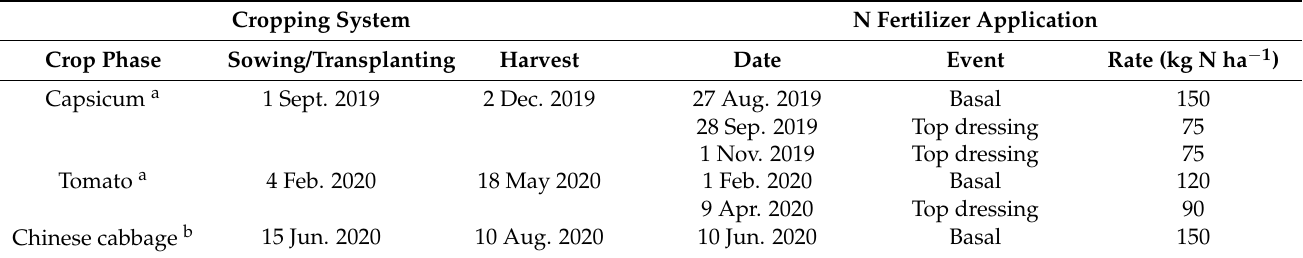
Table 1. Field managements, N fertilization events and rates over the annual vegetable cropping rotation. Cropping